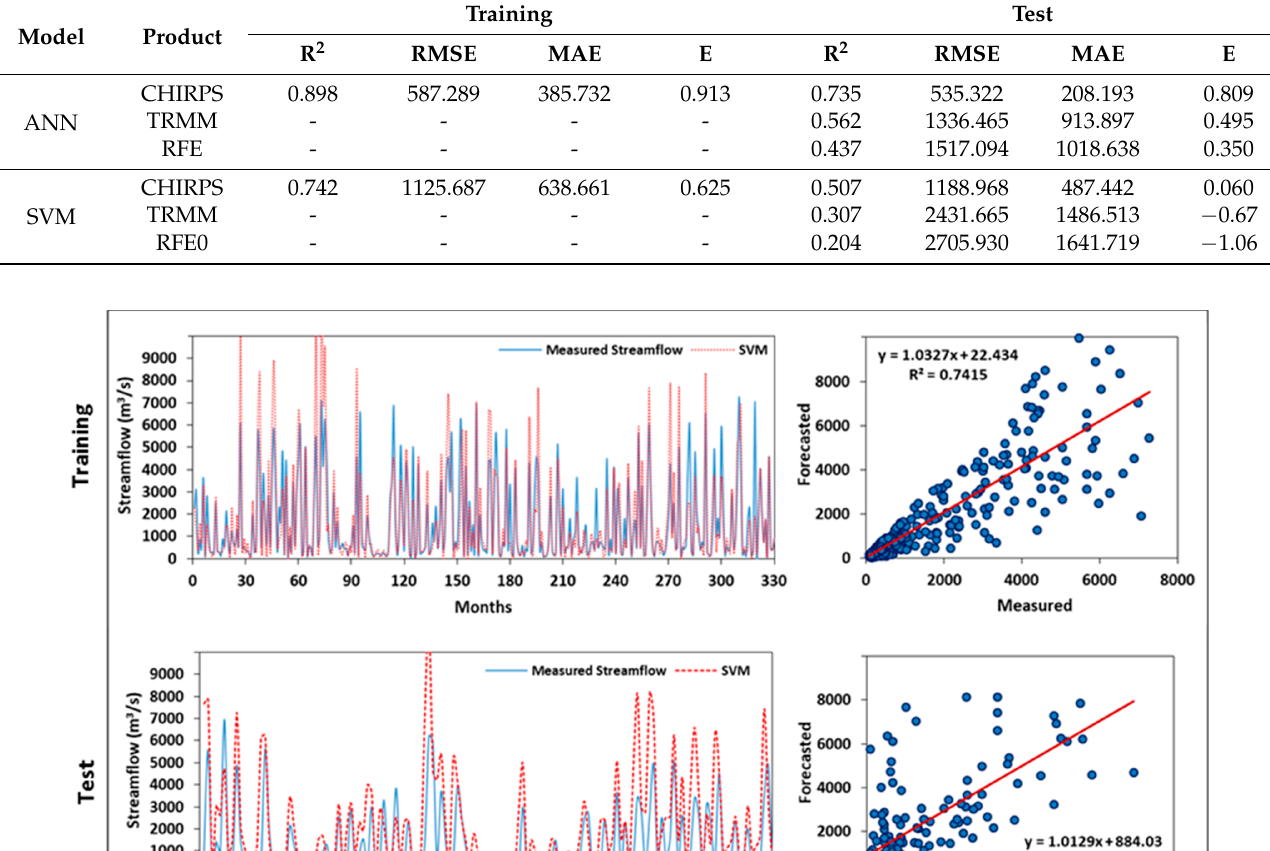
Figure 9. ANN training and test results of the simulated monthly streamflow at El Diem station based on the CHIRPS dataset.